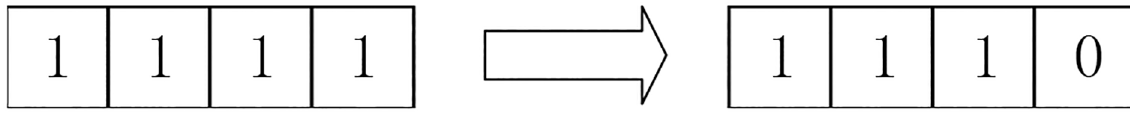
Fig 5. An example of mutation